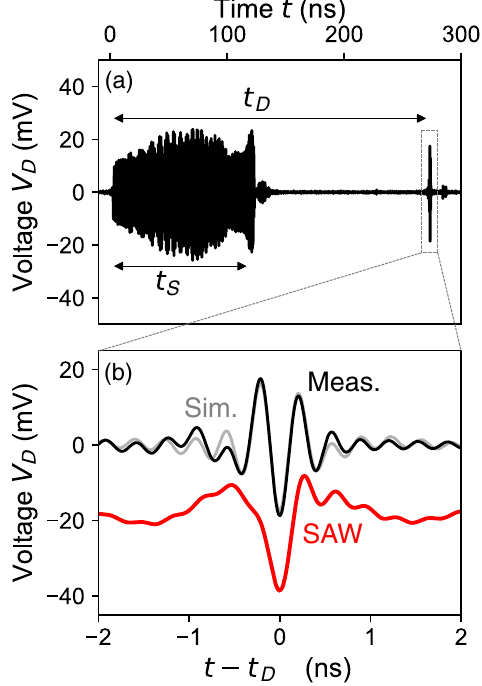
FIG. 4. Time-resolved measurements. (a) Trace of detector response for the frequency-modulated input signal applied on the chirp IDT with t S ≈ 120 ns. After initial electromagnetic crosstalk ( t ¼ 0 ns), SAW arrives at the expected delay time t D . FIG. 3. Frequencyresponse.Transmissionmeasurementbetween opposing chirp IDTs (black) with simulation via the delta-function (b) Zoom-in of the time window around t D , which shows the model (gray) and indications of the passband ranging from f 1 ≈ detected voltage pulse (black) with impulse-response simulation 0 . 5 GHz to f ≈ 3 . 0 GHz. Notethatthe transmissionbandwidthof (gray) and the corresponding SAW shape (red; with offset and N arbitrary units) derived via deconvolution of the detector the radio-frequency lines is not considered in the